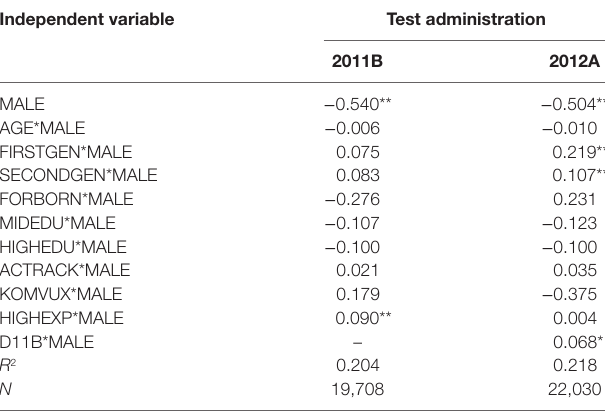
taBlE 4 | Least squares estimates of gender differences in ranking of grade point average (GPA) vs Swedish admissions test (SweSAT).